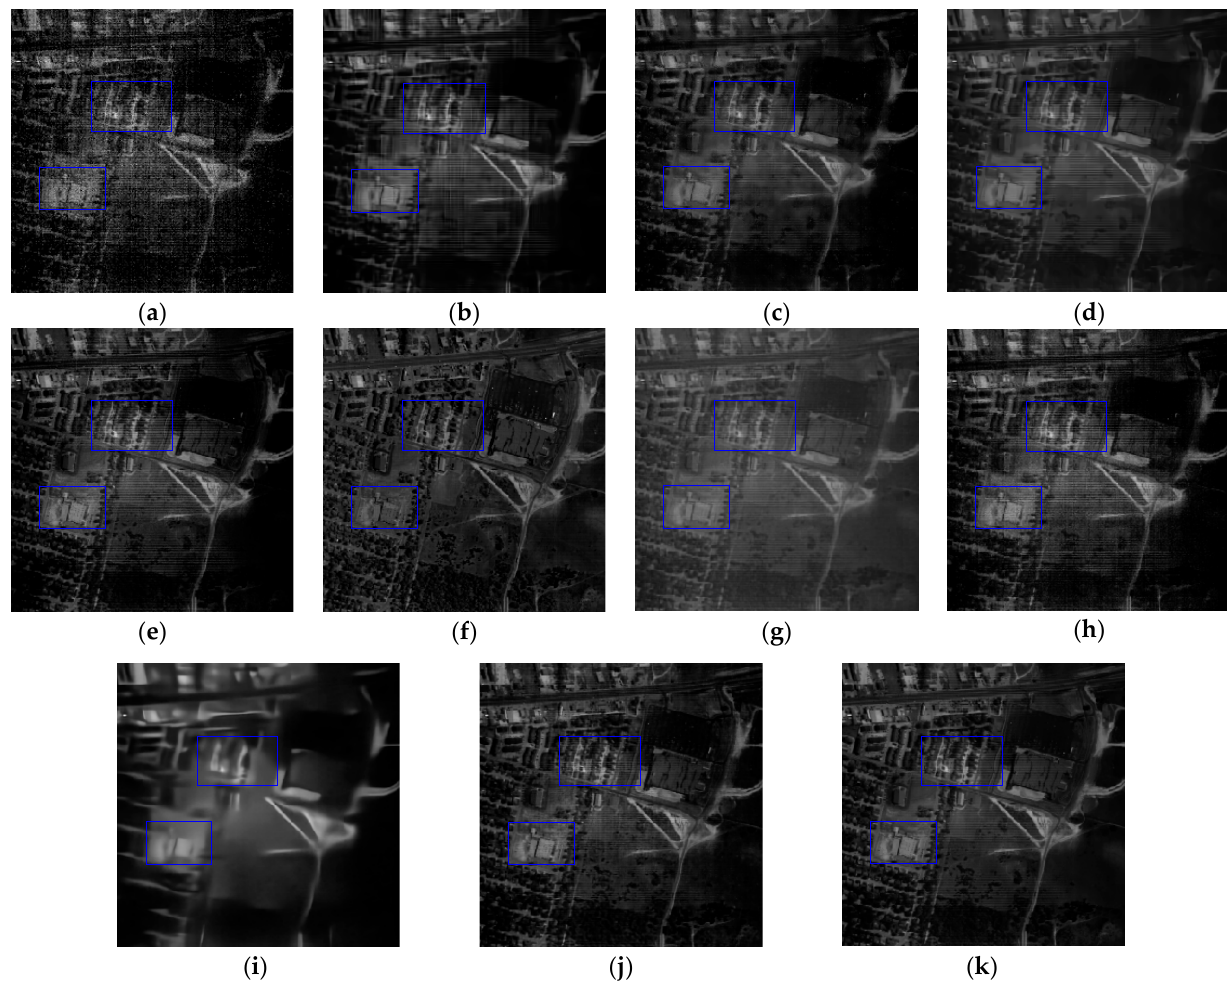
Figure 9. Restored results of the Urban image: ( a ) original band 109; ( b ) BM3D; ( c ) ANLM3D; ( d ) BM4D; ( e ) LRMR; ( f ) GLF; ( g ) LRTDTV; ( h ) LTDL; ( i ) DnCNN; ( j ) HSID-CNN; ( k ) VLRMFmcl. The blue boxes are used to facilitate the comparison by marking the differences from the results obtained by different algorithms.